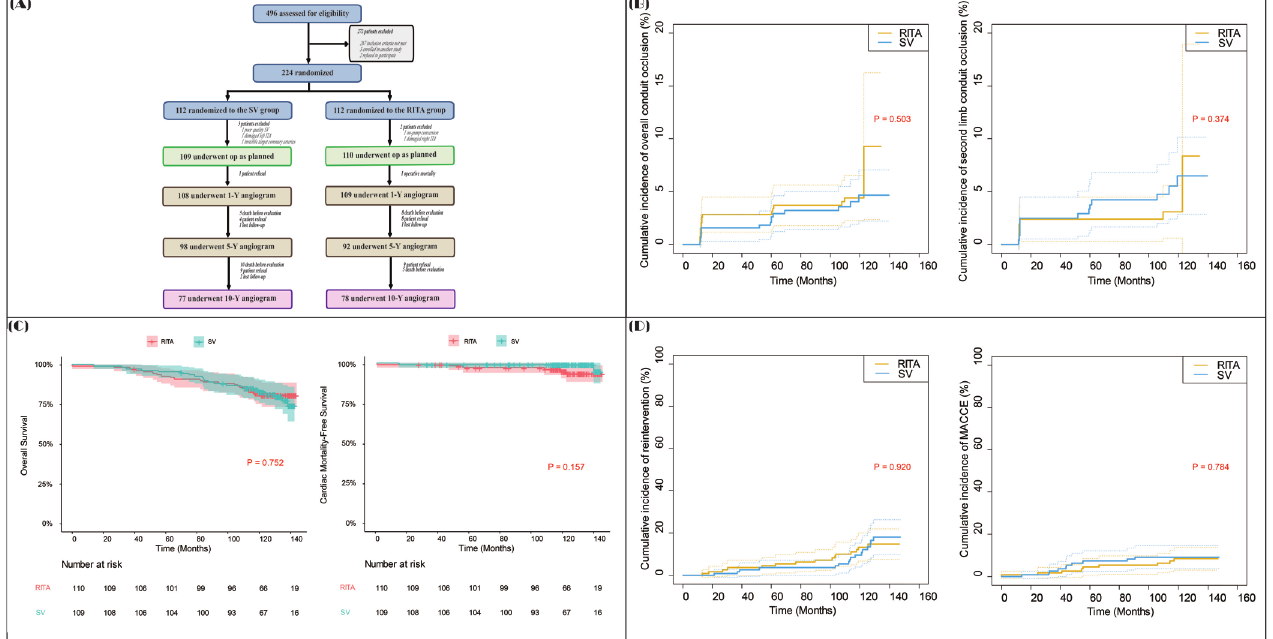
Fig. 2 - Long-term angiographic and clinical results of the SAVE RITA trial. (A) Summary flow diagram of patients. Comparison of (B) cumulative incidence of the overall conduit and second-limb conduit occlusion, (C) overall survival and cardiac mortality-free survival, (D) cumulative incidence of reintervention and major adverse cardiac and cerebrovascular events (MACCE) between the saphenous vein (SV) and right internal thoracic artery (RITA) groups. ITA=internal thoracic artery; SAVE RITA=SAphenous VEin versus Right Internal Thoracic Artery